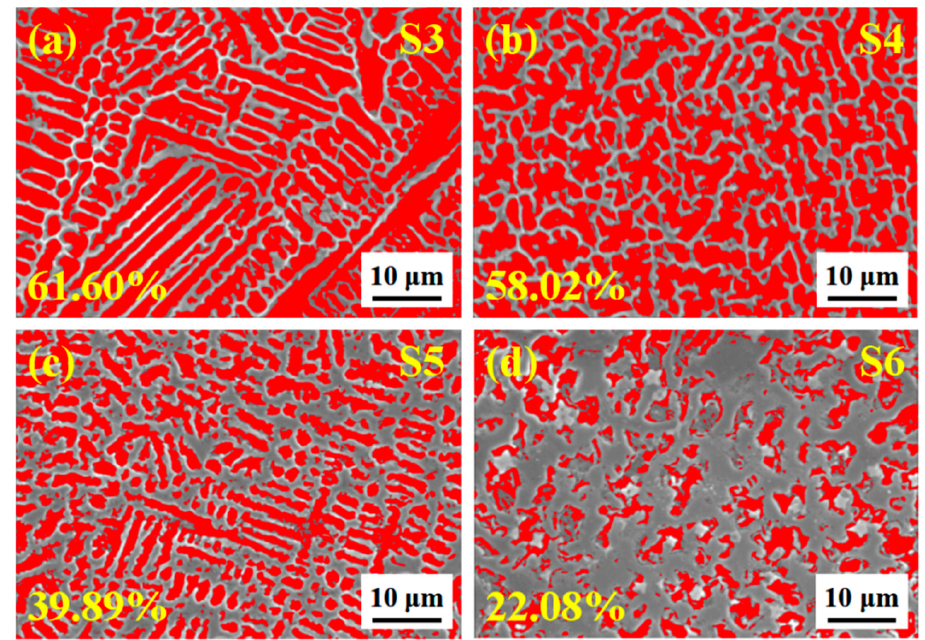
Figure 13. Quantitative analysis image and porosity of corrosion area in Figure 12. ( a ) S3; ( b ) S4; ( c ) S5; ( d ) S6. Table 3. Elemental concentrations of the corrosion areas in Figure 12